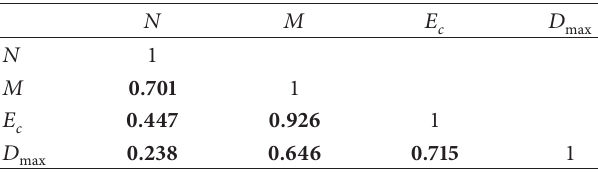
Table 1: Correlations between hailfall parameters measured. Bold type shows significant correlations at 0.01